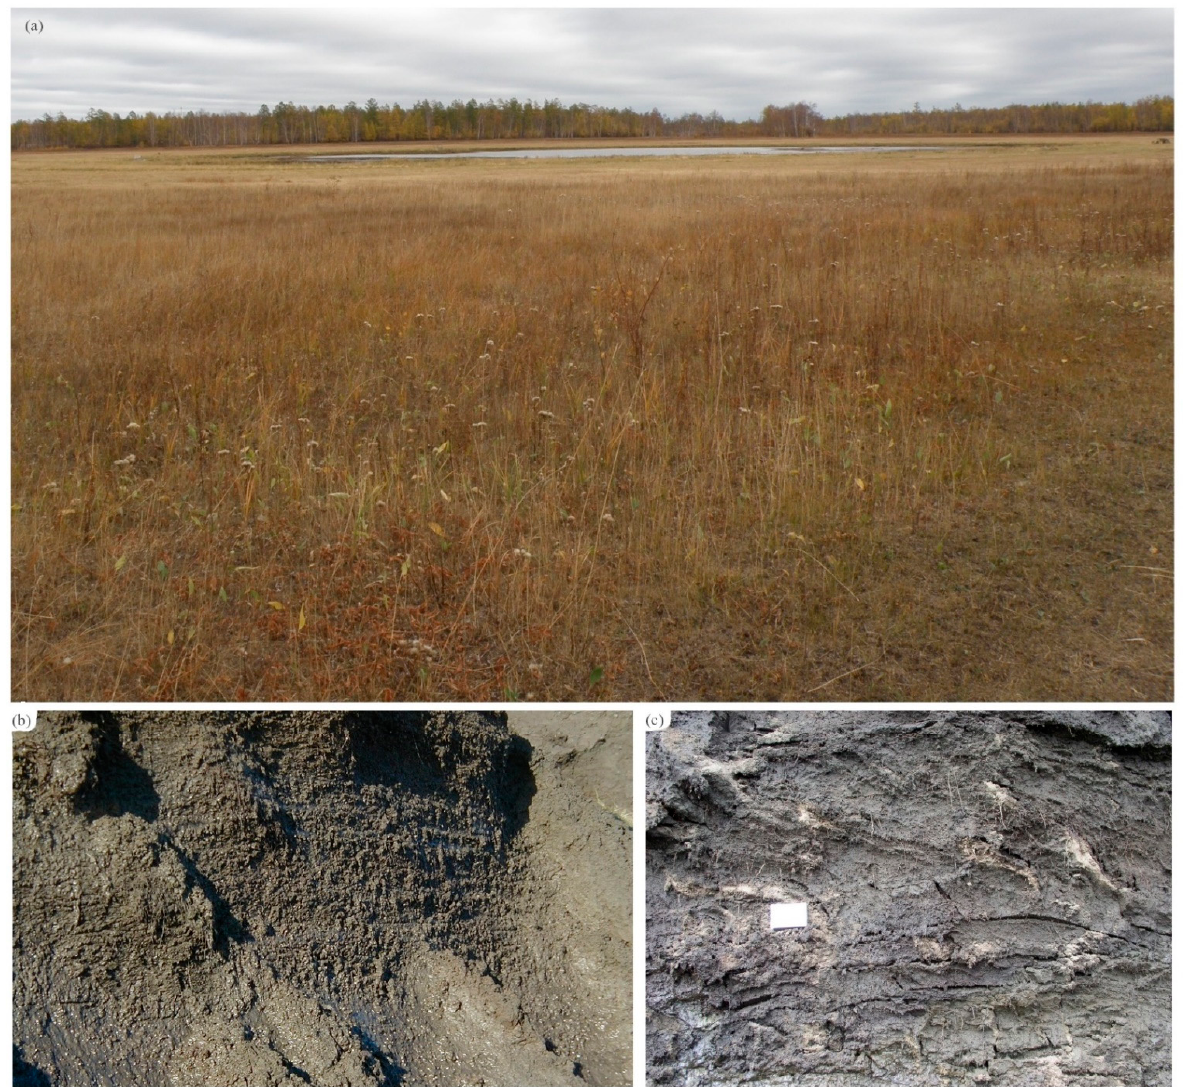
Figure 4. Sources of insects in Yedoma deposit: ( a ) lake in steppe meadow near Yakutsk, ( b ) silt with tiny grass roots, Bykovsky Peninsula, ( c ) sandy silt with grass roots, Main River, Chukotka.